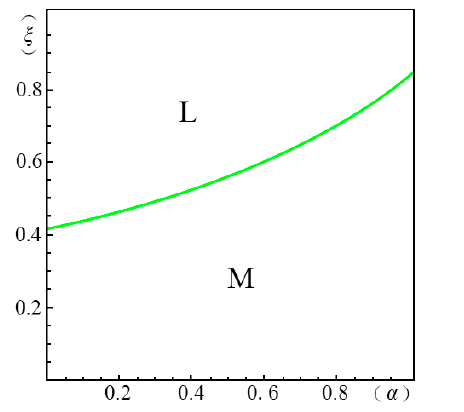
− p 1 A < p 2 A + kg − p (cid:3407) (cid:3043) (cid:3118)(cid:3250) (cid:3397)(cid:1863)(cid:1859) (cid:2879)(cid:3043) . . Figure 7. Comparison of the four strategies given δ = 3 when p 2 A σδ Q − 1 σδ Q ( 1 − λ ) (cid:3097)(cid:3083)(cid:3018)(cid:4666)(cid:2869)(cid:2879)(cid:3090)(cid:4667) (cid:3097)(cid:3083)(cid:3018)(cid:2879)(cid:2869)